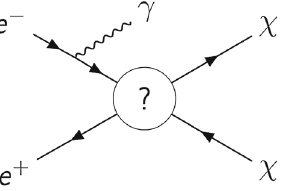
Fig. 1 Diagram describing DM particle pair production process with additional ISR photon